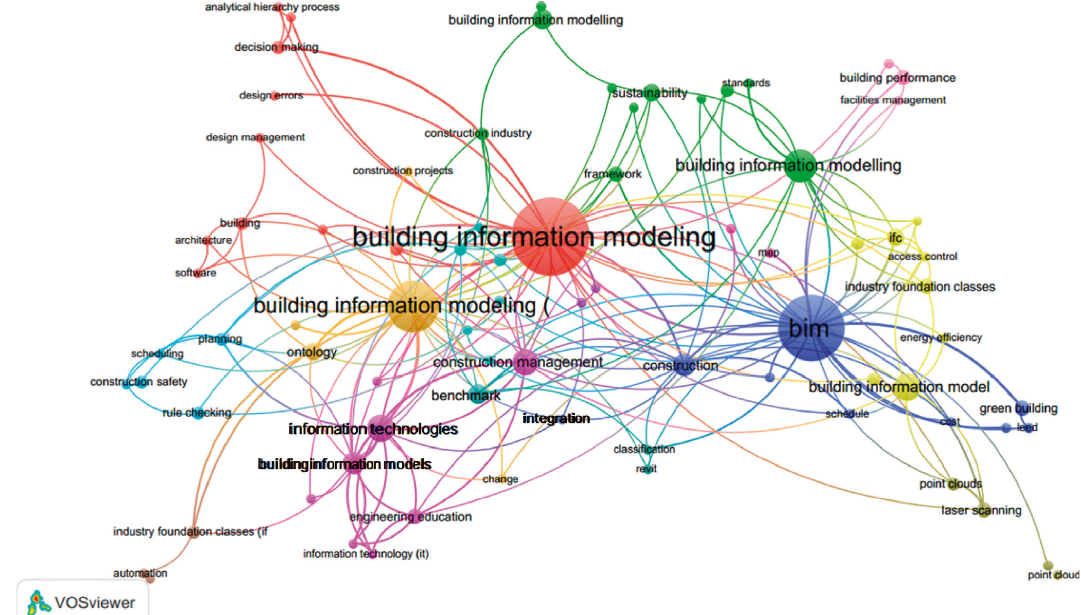
Figure 4: The cooccurrence network of keywords for the studies on integration in BbCNs describing the nodes of benchmark , construction, and information technologies closely related to integration